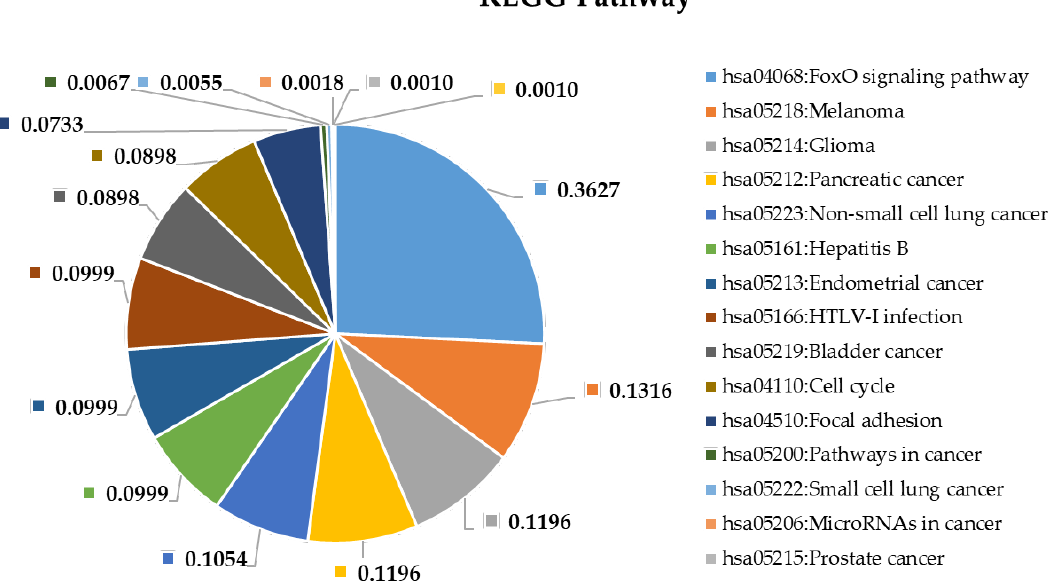
Figure 5. Functional annotation enrichment of target genes of the top 38 deregulated miRNAs based on their enrichment in Gene Ontology GO_ Molecular Function. Significance of the selected (?) pathways are characterized by their FDR values shown inside the chart sections.